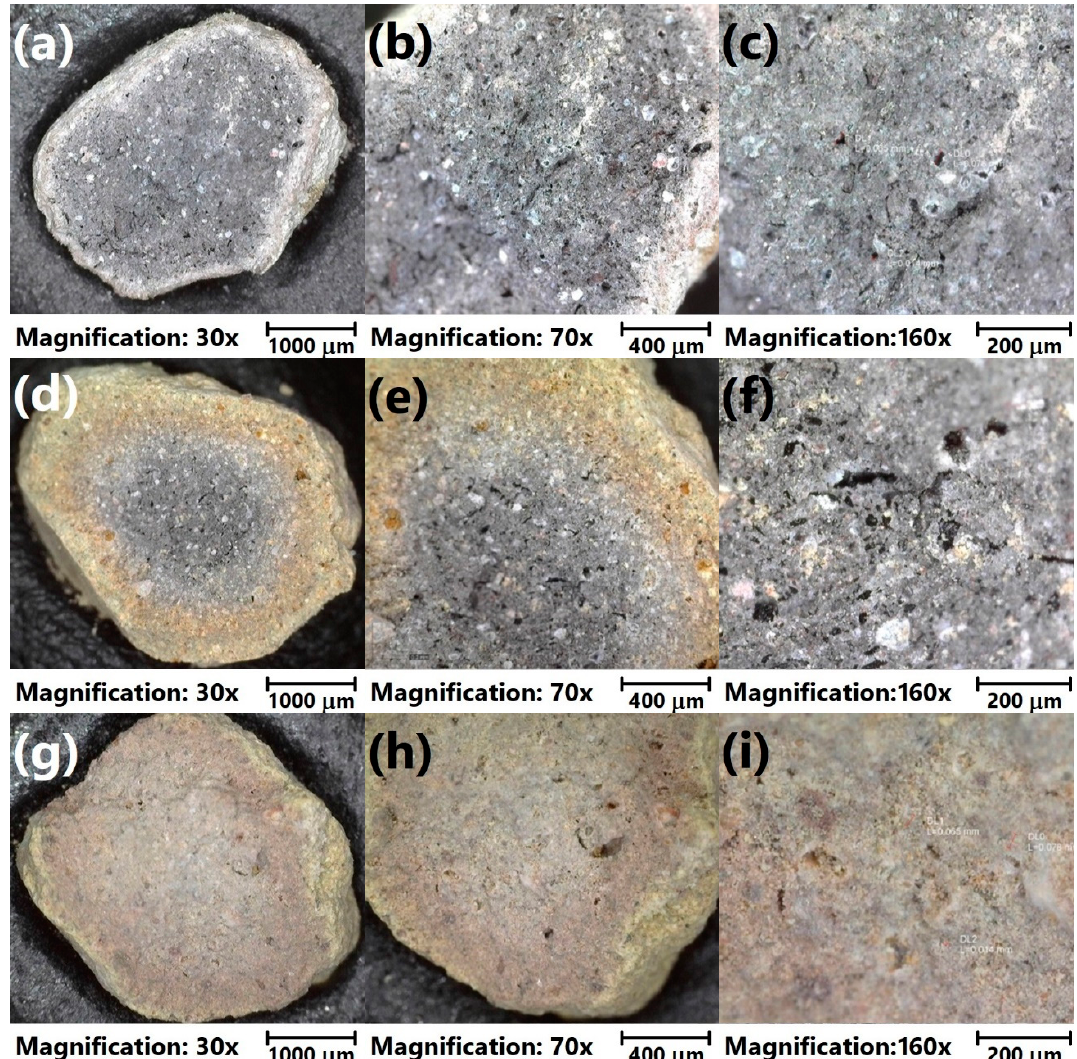
Figure 6. Images of fracture surfaces of ( a – c ) C 30 SS 50 , ( d – f ) C 40 SS 40 , and ( g – i ) C 50 SS 30 LWAs under different magnifications.